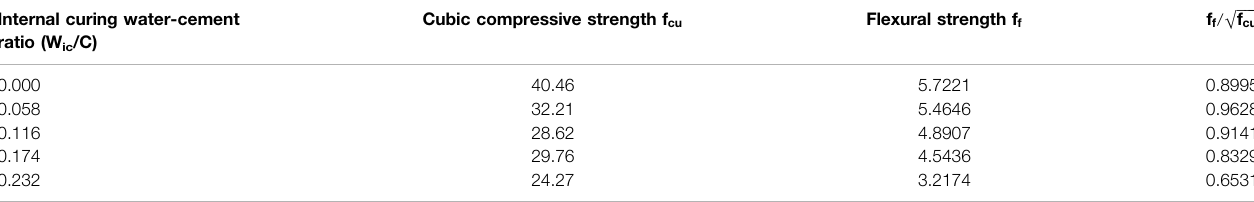
TABLE 5 | The quasi fl exure-compression ratio of SAP